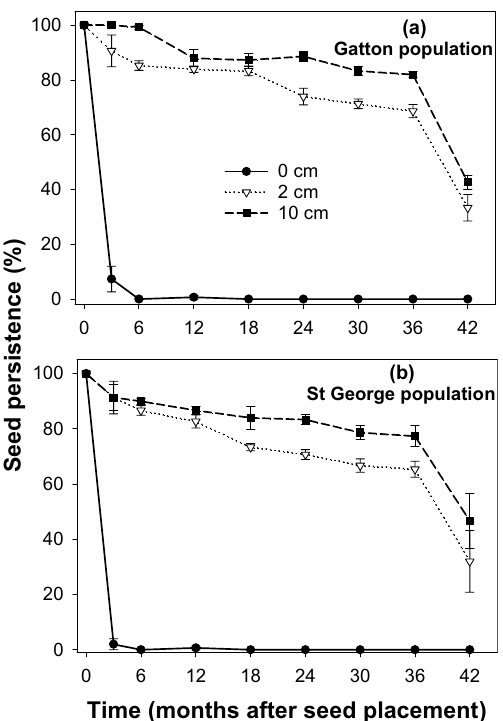
Figure 7. Seed persistence of Argemone mexicana seeds from Gatton ( a ) and St George ( b ) locations placed in mesh-bags at 0, 2 and 10 cm depths, symbols correspond to mean and error bars are the standard error of means (n = 3).